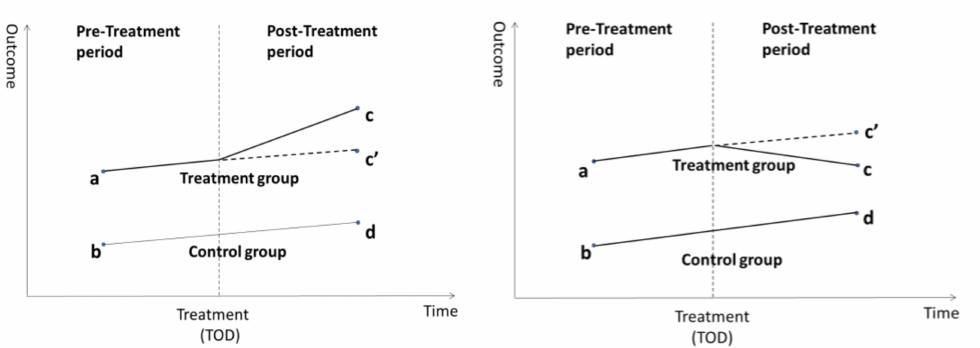
Figure 1. Difference-in-difference (DiD) design and randomness with pre-treatment